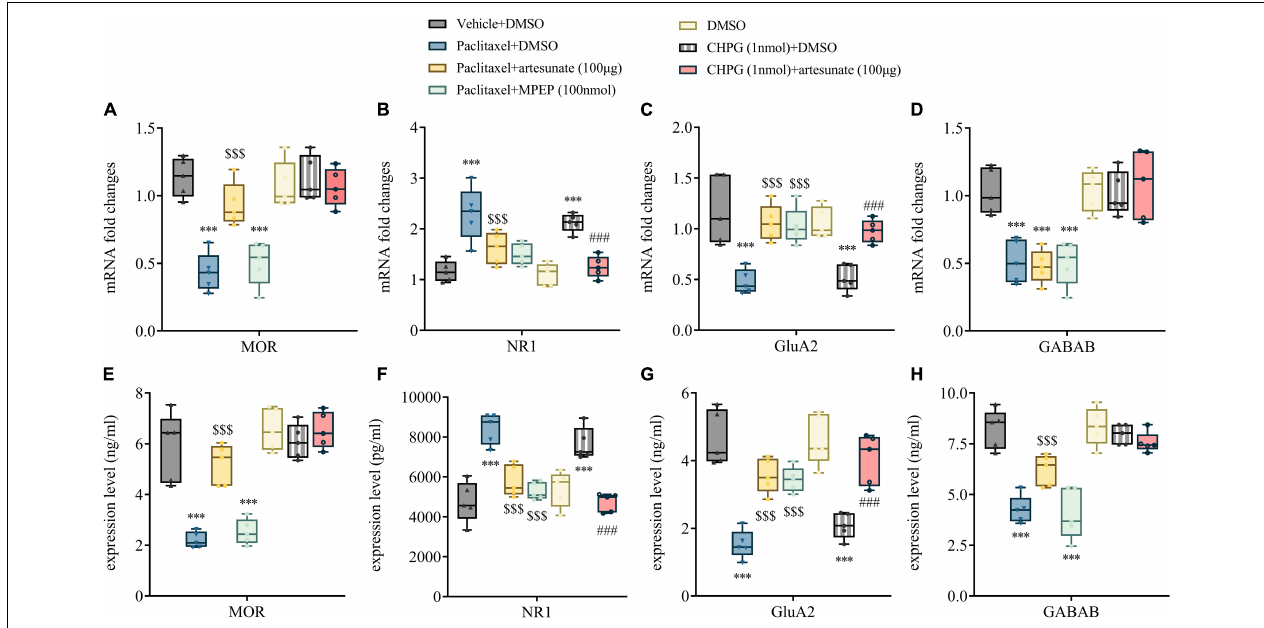
FIGURE 5 | Artesunate alleviates PINP by regulating NR1 and GluA2 in DRGs via mGluR5 in mice. Bilateral L3-5 DRGs were obtained from mice 10 days following the initial paclitaxel treatment. qRT-PCR detected MOR (A) , NR1 (B) , GluA2 (C) , and GABAB (D) mRNA expression levels in DRGs, expressed as fold elevation vs. Vehicle + DMSO group, with GAPDH utilized as a reference. ELISA detection of the DRG levels of MOR (E) , NR1 (F) , GluA2 (G) , and GABAB (H) in mice. Data are median with interquartile ranges, and individual data points are shown ( n = 5). *** P < 0.001 vs. Vehicle + DMSO group; $$$ P < 0.001 vs. Paclitaxel + DMSO group; ### P < 0.001 vs. CHPG (1 nmol) + DMSO